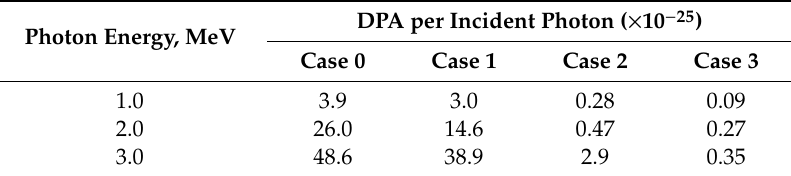
Table 3. Radiation damage due to gamma ray irradiation of the